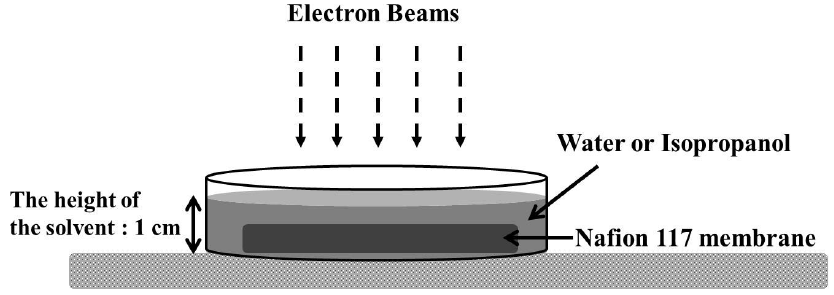
Figure 2. Irradiation of Nafion membrane soaked in a solvent with an electron beam (10 MeV, 0.5